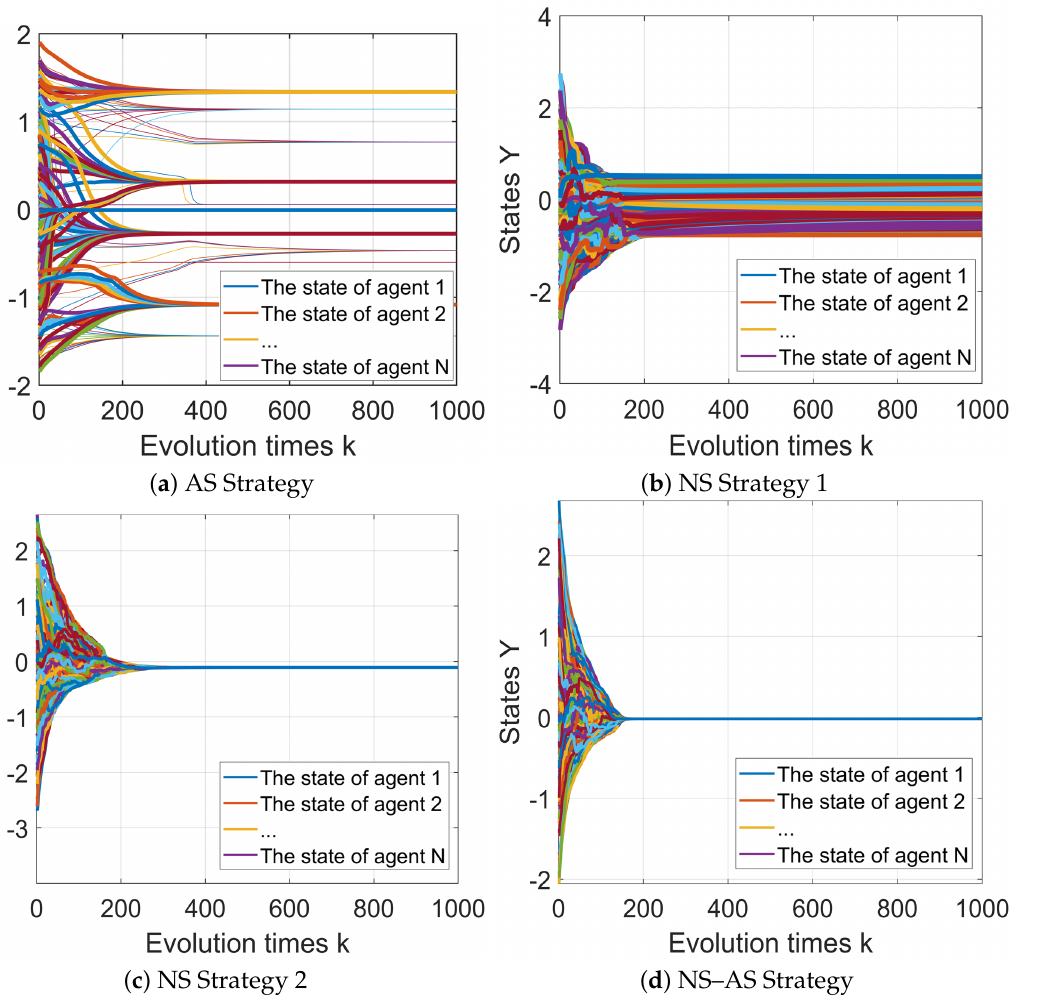
Figure 1. The evolution process of EA–CA model state information in different